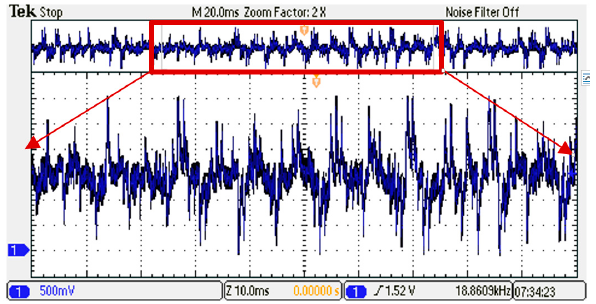
Figure 16. APD output during in vitro validation.